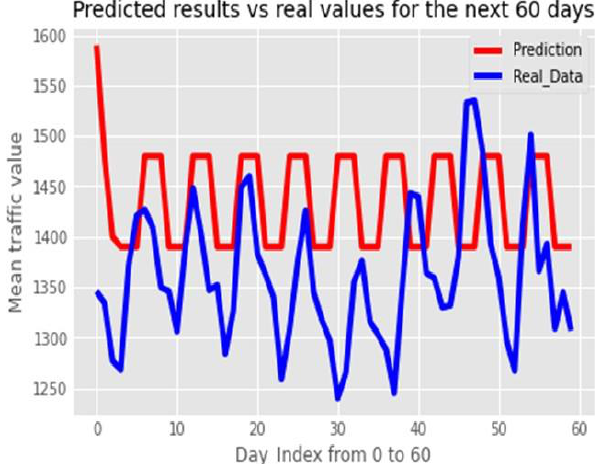
Figure 7. Prediction of mean traffic for learning rate LR=0.04 and β